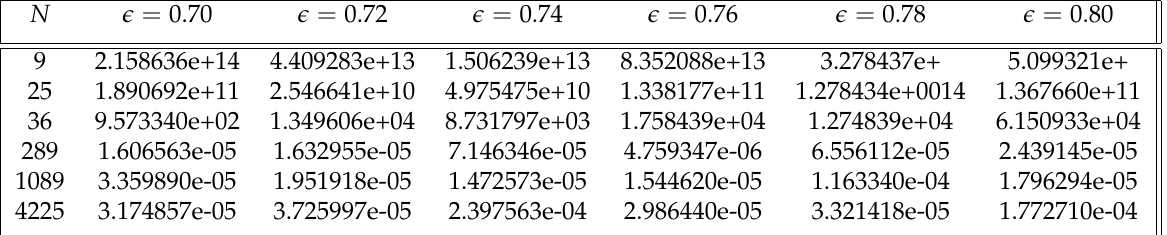
Table 4. RMSE for Equation 3 over a range of shape parameters ( (cid:101)